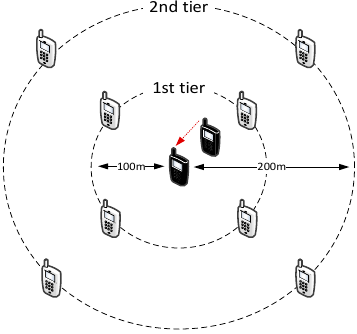
Figure 19. Simulation scenario for analysis of frequency reuse. Sensors 2018 , 18 , x FOR PEER REVIEW